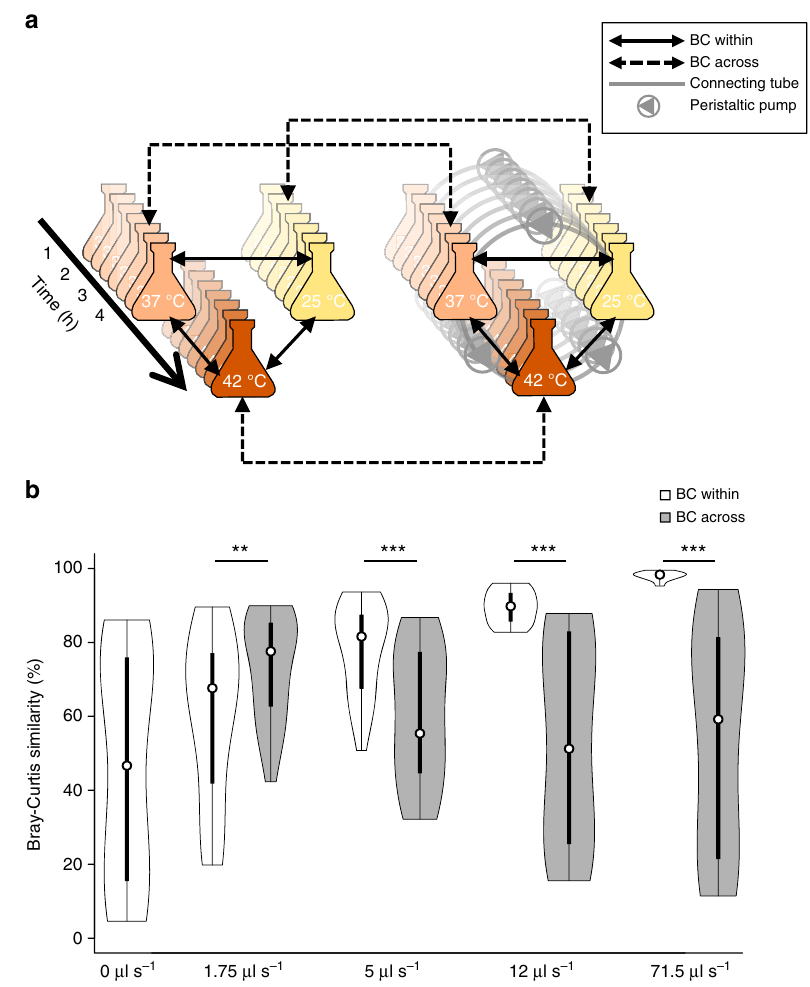
Fig. 3 Calculation method and changes in Bray – Curtis (BC) within and BC across. a The communities from the experiment without dispersal are shown on the left side of the panel and the communities from an experiment at a given circulation speed are shown on the right side. “ BC within ” compares communities from the same experiment and time point (and thus at different temperatures), whereas “ BC across ” compares communities at the same temperature and time point (and thus from different experiments). For each experiment performed at a given circulation speed, each metric is calculated as the average of three comparisons per time point (starting after the fi rst hour of incubation) for a total of 63 comparisons over three replicate experiments. b Black hollow circles within the boxes correspond to median values, vertical rectangles to 25 – 75% boxplots, and vertical lines to the range of the remaining observations. The sides of the boxes correspond to the kernel density of the observations. Asterisks correspond to p values of linear mixed- effects models comparing “ BC within ” to “ BC across ” at each tested circulation speed ( n = 63, double asterisks (**) and triple asterisks (***) for corrected two-sided p between 0.01 and 0.001 and p < 0.001, respectively). Source data are provided as a Source Data fi